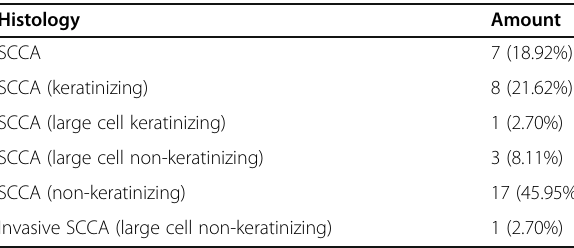
Table 1 Histology of patients ’ cancer ( SCCA squamous cell carcinoma)